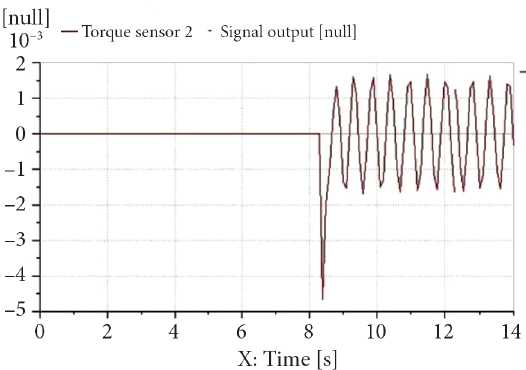
Fig. 12. Torque generated in the model of the system due to a ramp torsion